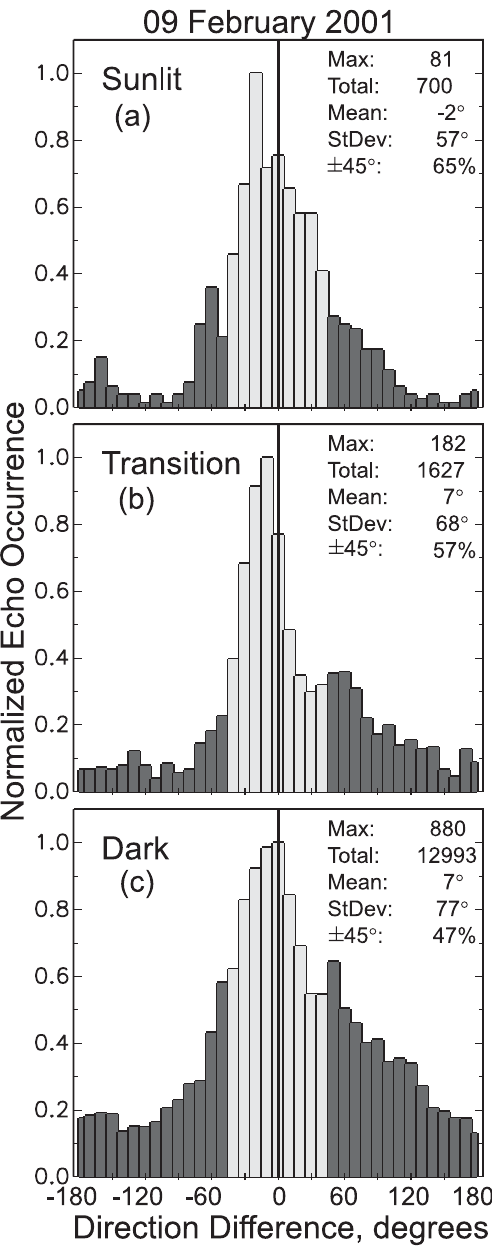
Fig. 4. Statistical distributions for the angle 1θ (the azimuth differ- ence between the SuperDARN velocity and the magnetic equivalent convection vectors) on 9 February 2001 (near vernal equinox). The comparison is performed for the (a) sunlit, (b) transition, and (c) dark ionospheric regions. 10 ◦ bins of 1θ are used. The histograms are normalized to one. Also shown are the number of points cor- responding to the bin of the distribution maximum, total number of points available, the mean value of the distribution (in degrees), the standard deviation of the distribution (in degrees), and the percent- age of data points with 1θ within ± 45 ◦ .